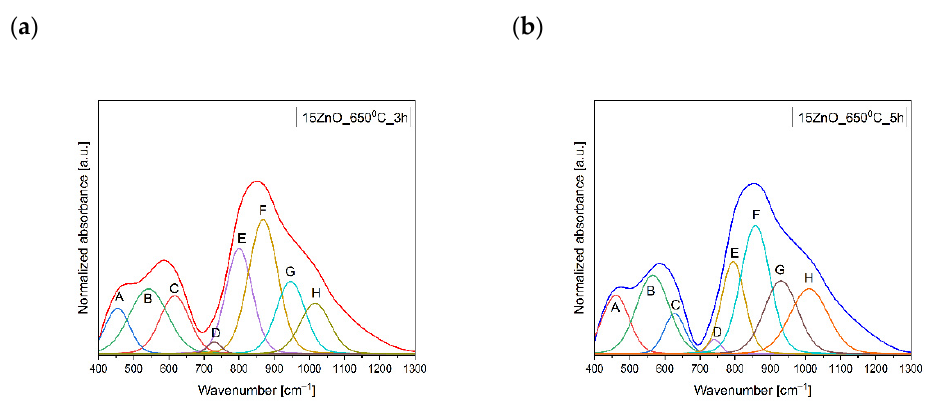
Figure 3. MIR spectrum of the 15ZnO glass co-doped with Ni 2+ and Er 3+ . ( a )